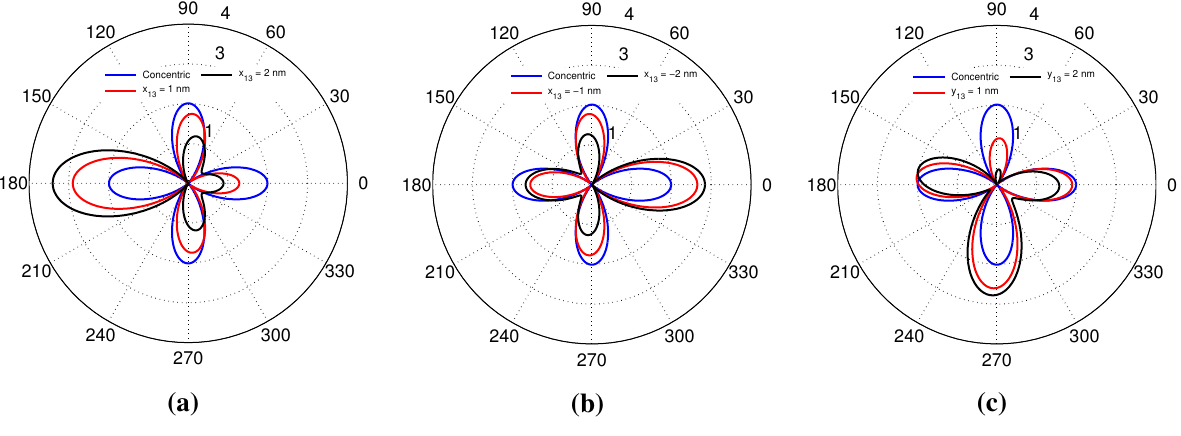
Figure 10. The directivity of the concentric and eccentric 3L NPs for κ = − 0 . 6202 at the shorter wavelength around 421 nm. The directivity is shown for core displacements along ( a ) the positive and ( b ) the negative x and 5